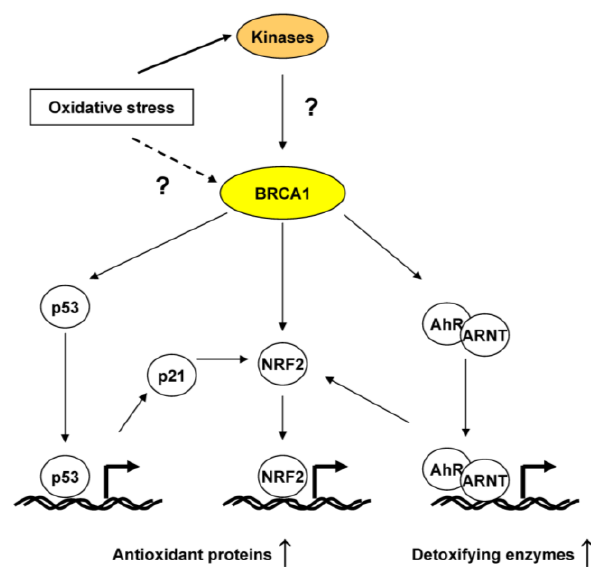
Figure 2. BRCA1 in the oxidative stress